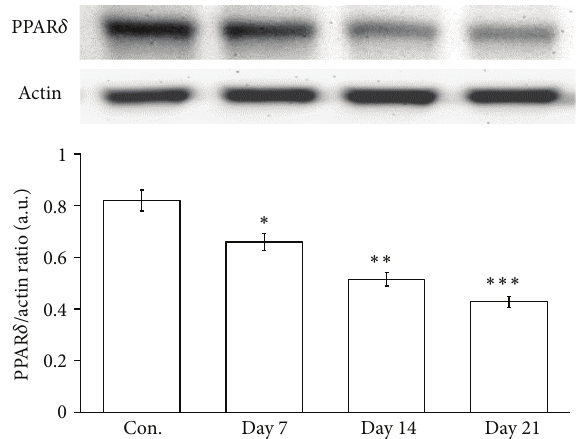
Figure 5: Changes in PPAR 𝛿 expression in the spinal cord of STZ- diabetic rats after SCI. PPAR 𝛿 expression in the spinal cord of the two-week induction STZ-diabetic rats was investigated on the 7th, 14th, and 21st days after SCI. Data represent the mean ± SEM of six animals. ∗ 𝑃 < 0.05 , ∗∗ 𝑃 < 0.01 , and ∗∗∗ 𝑃 < 0.001 compared with the sham-operated group